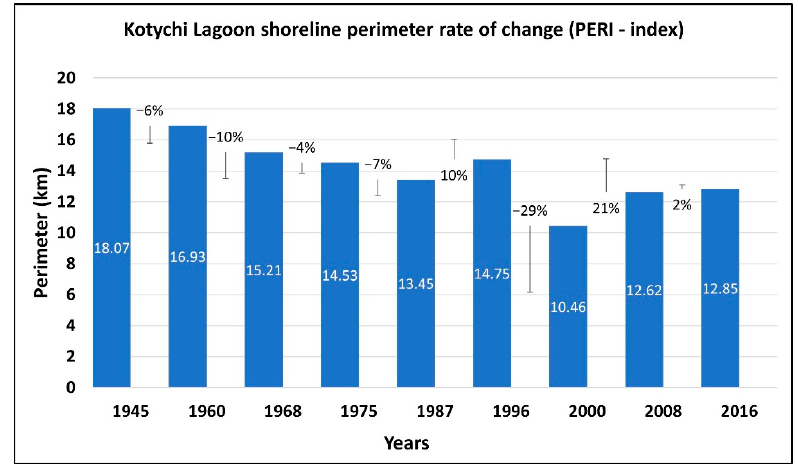
Figure 9. Perimeter fluctuations (%) during the study period in the Kotychi Lagoon. Table 3. Geometrical parameters of Kotychi Lagoon.